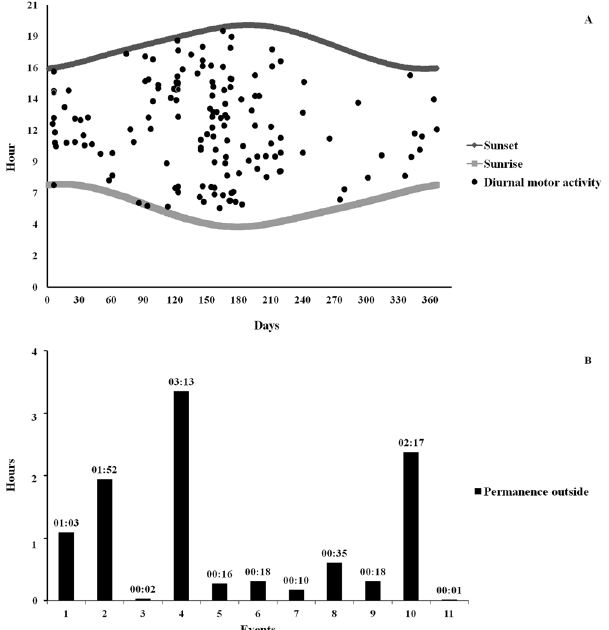
Figure 1. Graphical representation of the 148 events of diurnal motor activity recorded in the monitored settlement in relation to the hour of sunset and sunrise during the year (21 December–20